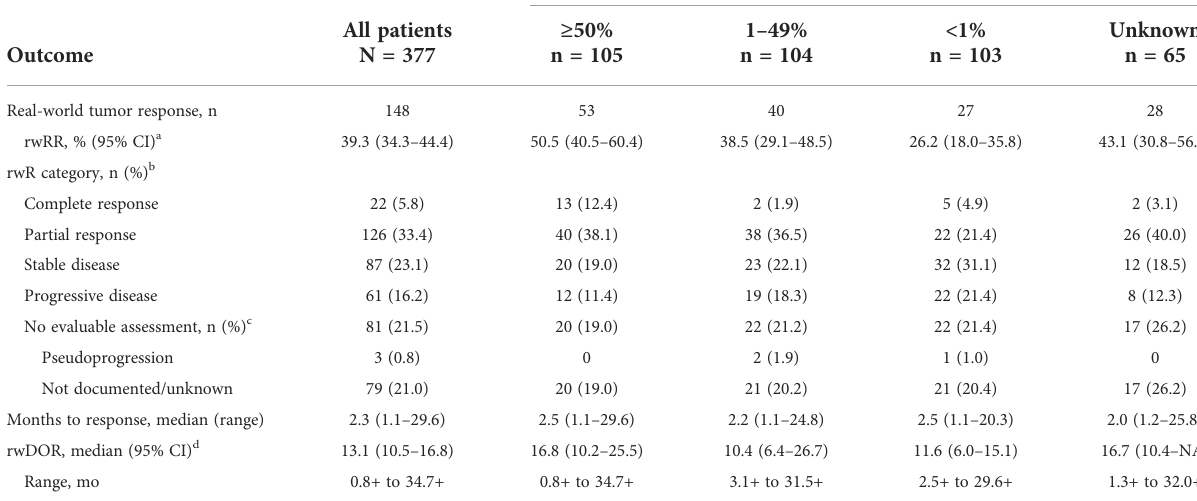
TABLE 4 Real-world tumor